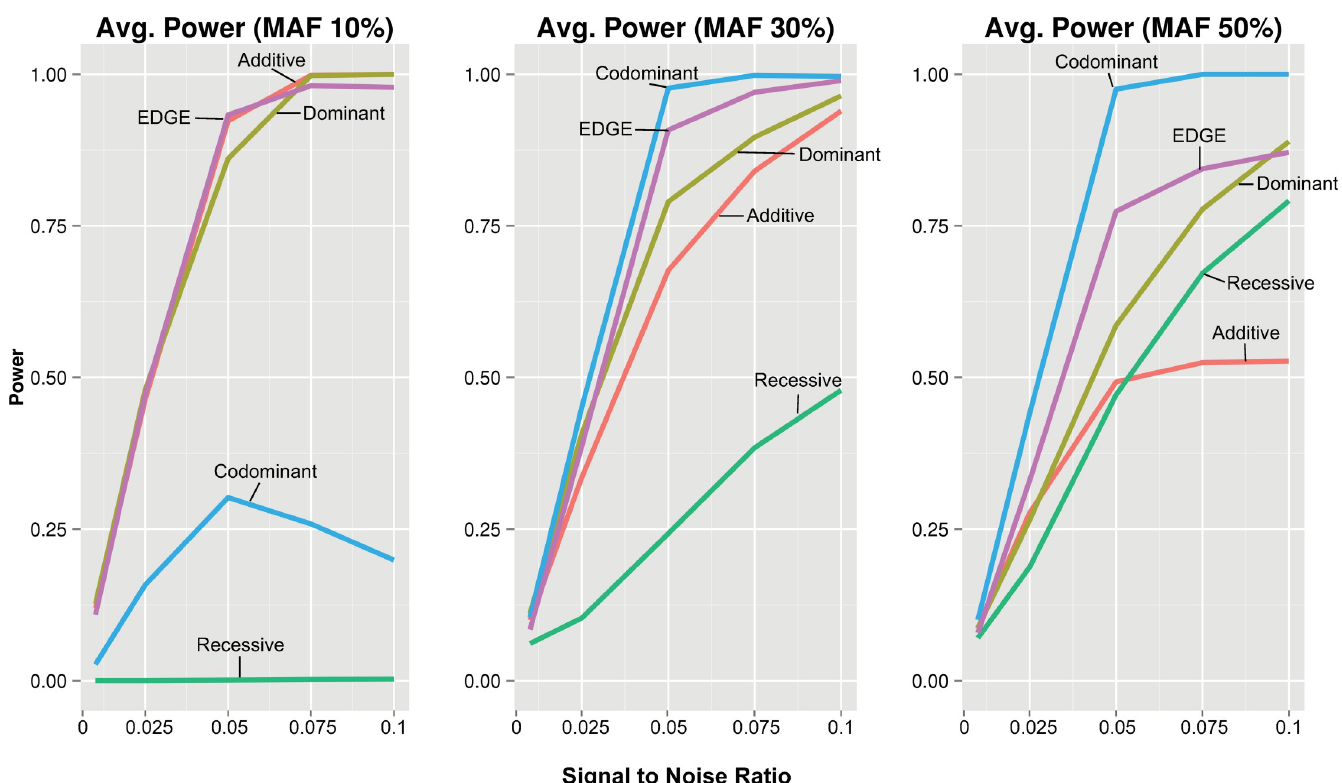
Fig 6. Average power for standardized signal to noise ratio across all genotype-based interaction models at 10%, 30% and 50% MAF. Average power was calculated for standardized increasing signal to noise ratios and plotted at increasing signal to noise ratios for the genotype-based SNP-SNP interaction models using each encoding: additive (red), dominant (yellow), recessive (green), codominant (blue), and EDGE